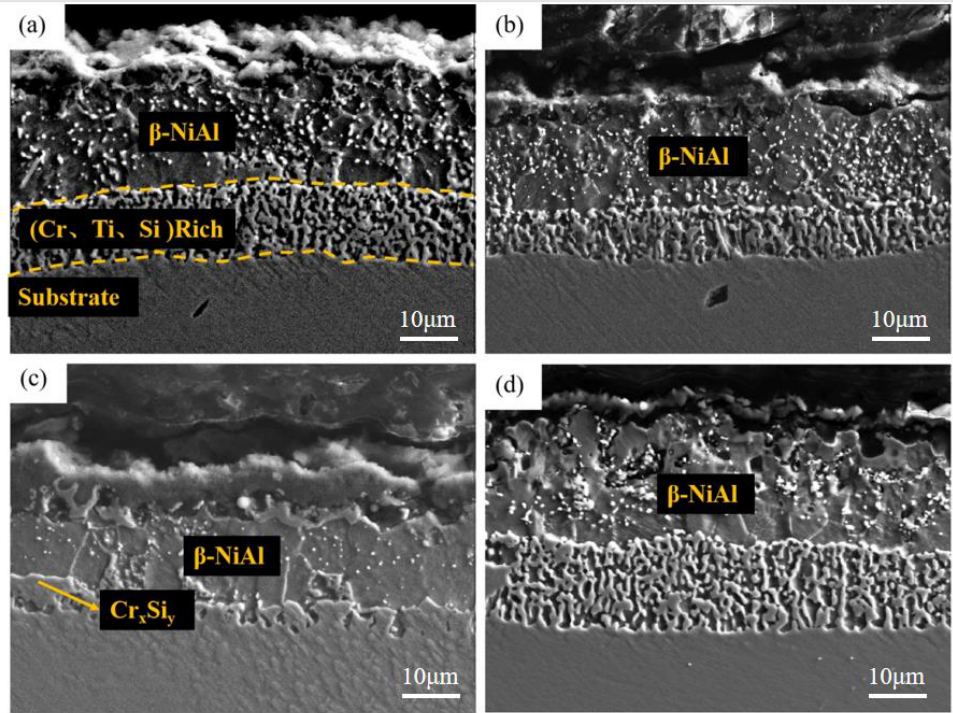
Figure 14. Cross-sectional morphologies of Al-Si coatings with different pre-oxidation times: ( a ) 3 h; ( b ) 5 h; ( c ) 7 h; ( d ) 9 h. After pretreatment at different pre-oxidation temperatures, Cr and Si are mainly dis- tributed in the diffusion zone below the diffusion layer and combine with refractory par-